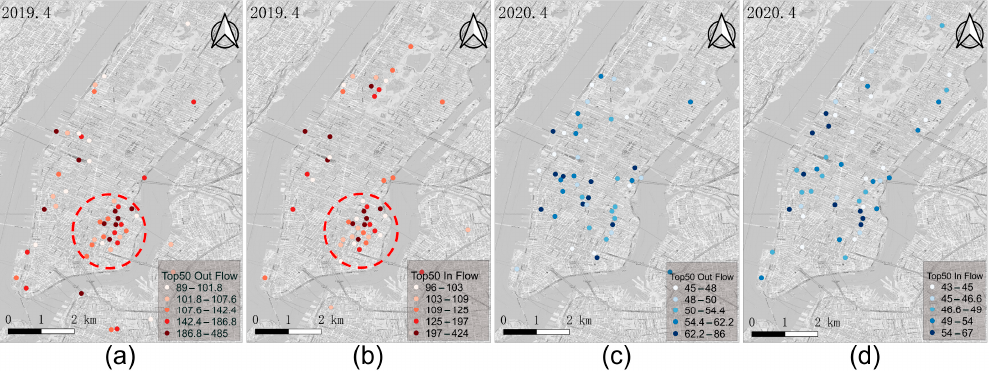
Figure 15. Top 50 stations with the highest transfer volume ( a ) Top 50 out flow stations in 2019.4 ( b ) Top 50 in flow stations in 2019.4 ( c ) Top 50 out flow stations in 2020.4 ( d ) Top 50 in flow stations in 2020.4.